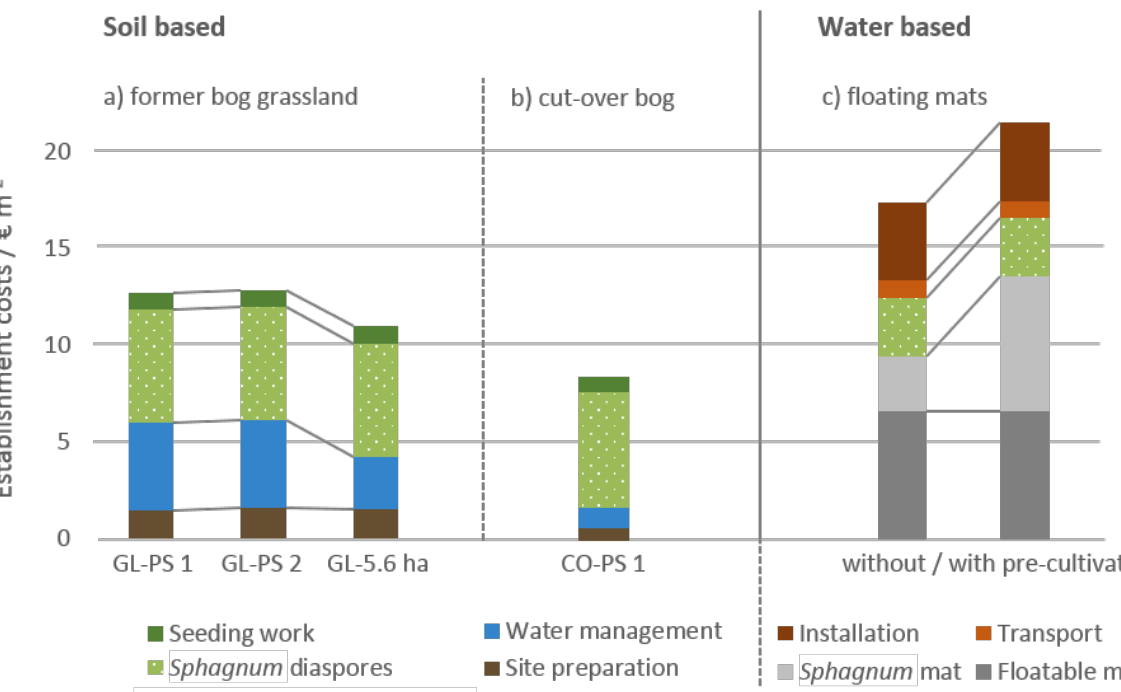
Figure 6. Establishment costs per net production area (€ m -2 ), from left to right: a) on bog grassland for GL-PS 1, GL-PS 2, and with proportionate investment costs for automatic water management reduced by considering the area enlargement from 2 ha to 5.6 ha moss production in 2016 (third column); b) on cut- over bog for a fictional site CO-PS 1 with assumed water supply by wind pump and mobile pump; c) on floating mats without (left column) and with (right column) pre-cultivation of Sphagnum